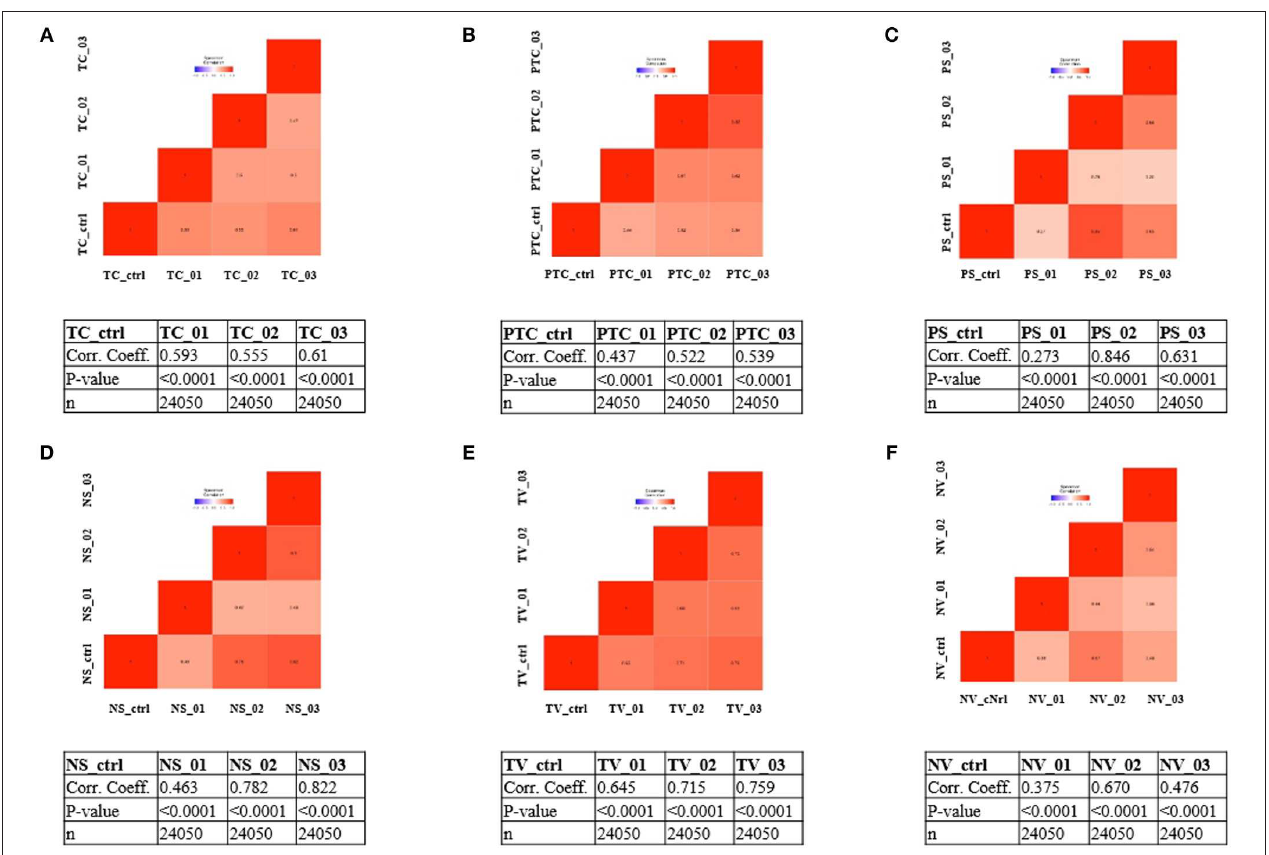
FIGURE 3 | Correlation matrix showing Spearman’s correlation coefficients of each experimental compartment RNA-seq raw data and experiments from the BioProject NCBI database as controls. (A) tumor core astrocytes—TC; (B) pseudopalisading astrocytes—PTC; (C) perineuronal astrocytes in satellitosis—PS; (D) neurons with satellitosis—NS; (E) tumor blood vessels—TV; (F) normal blood